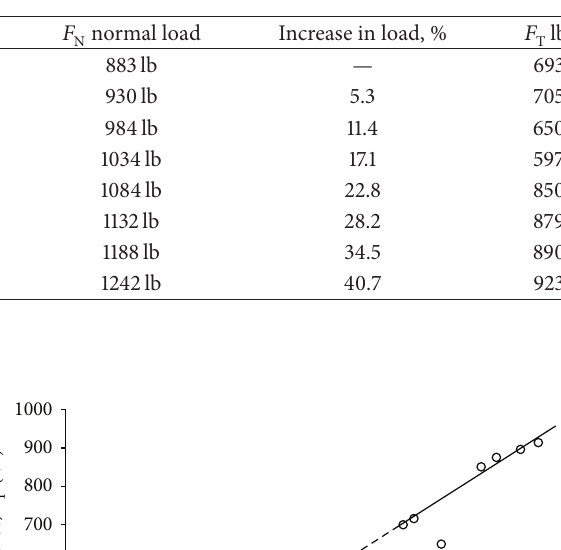
Table 2: Individual weights selected for use in controlling the ) applied to test tire during lockups and measured dynamic load ( 𝐹 N 𝐹 values dry asphalt pavement testing. T